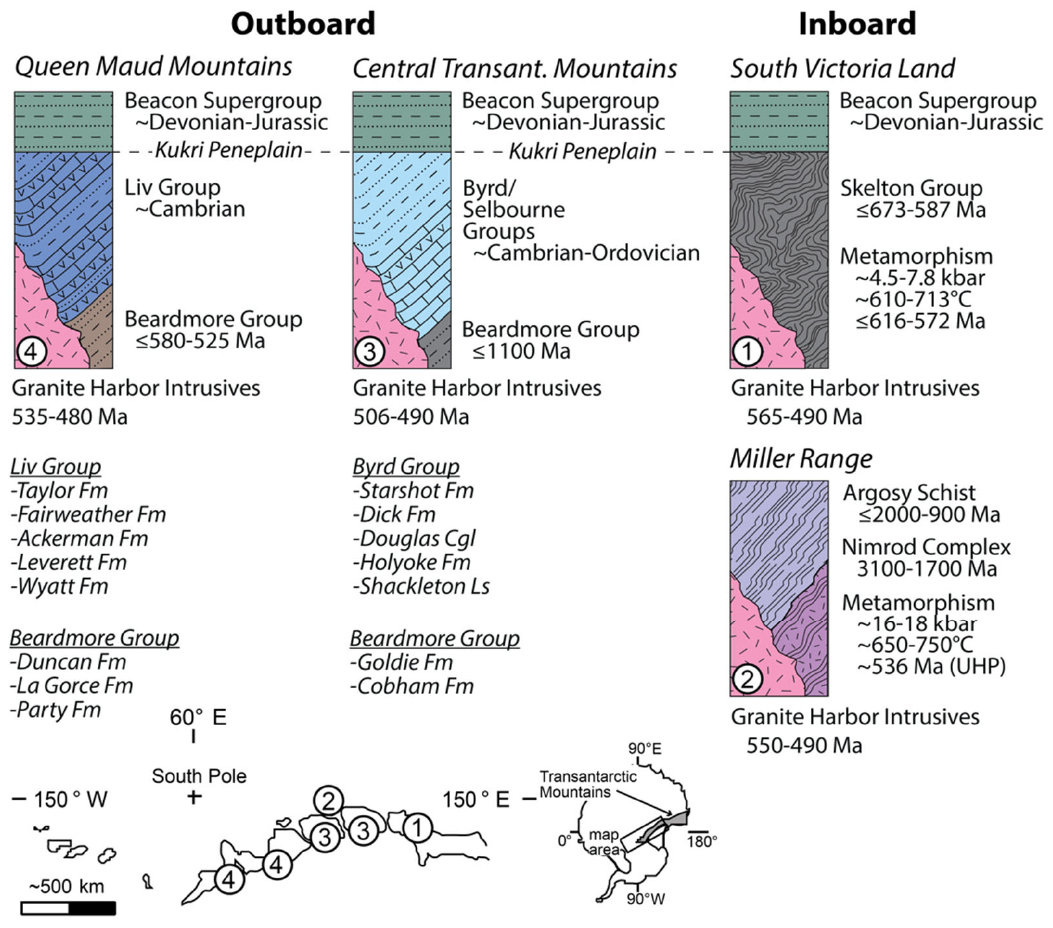
Figure 3. Schematic diagram summarizing the geology of the major rock packages found at outboard localities in the Queen Maud and central Transantarctic Mountains with respect to those found at inboard localities in the Miller Range and south Victoria Land. Ages and metamorphic conditions from sources provided in text.